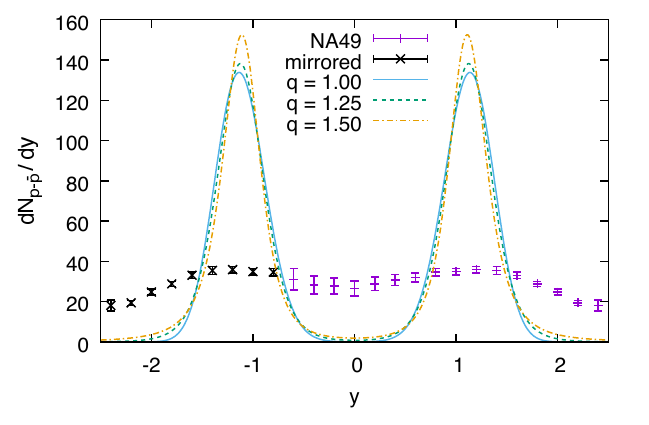
Figure 2. Numerical solutions of the nonlinear FPE for central PbPb at 17.2 GeV with three di ff erent values of q ∈ [1 , 1 . 5], and NA49 data [2]. From